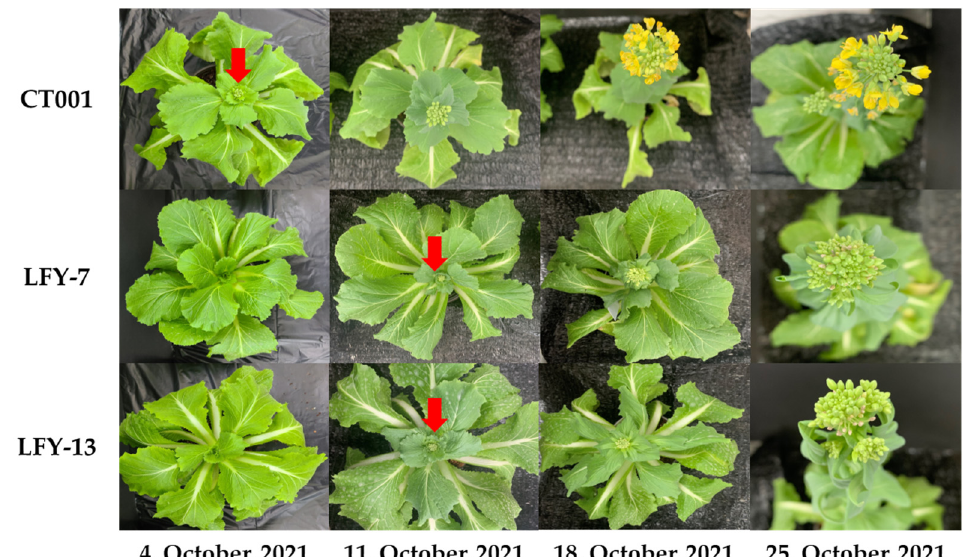
Figure 4. Confirmation of the bolting time and flower bud phenotype for ‘CT001’ and the E 0 LFY- edited lines. Red arrow, emergence of the first flower bud.